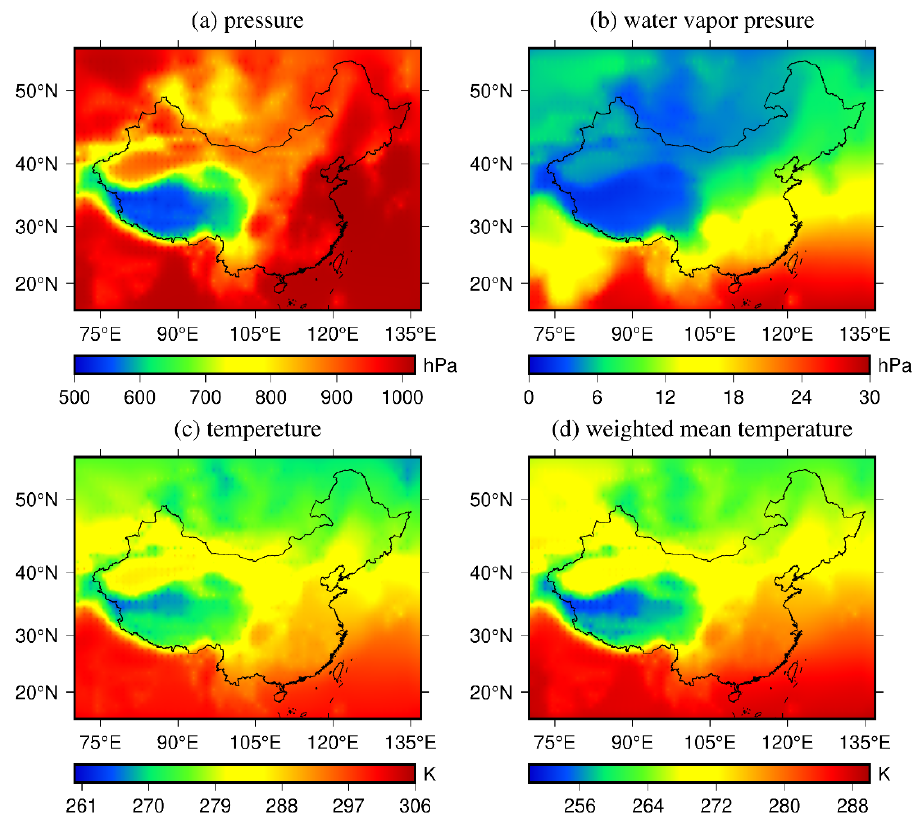
Figure 4. Distribution of the annual mean of the tropospheric parameters for pressure ( a ), parameters for water vapor pressure ( b ), parameters for temperature ( c ), and parameters for T m ( d ) calculated from MERRA-2 data.